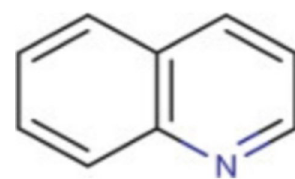
Fig. 4 Basic quinoline structure (an alkaloid). Source: [37]